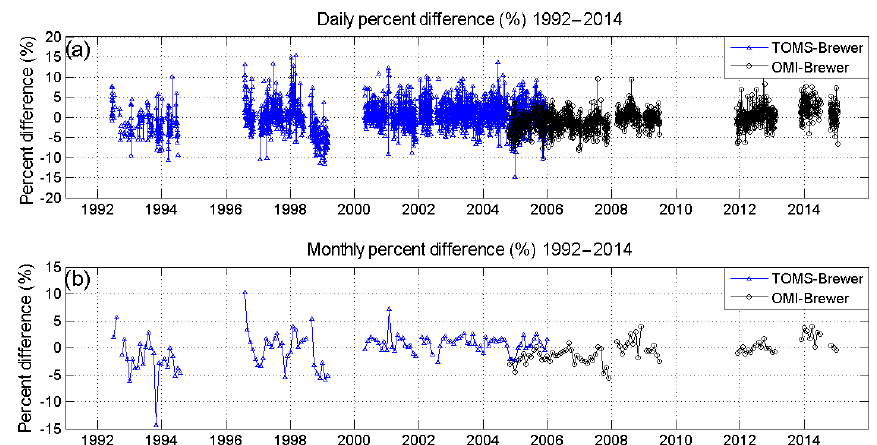
Figure 3. Top: time evolution of daily percentile differences between Brewer spectrophotometer and satellite instruments (with TOMS in blue and OMI in black). Bottom: time evolution of monthly percentile differences between Brewer spectrophotometer and satellite instruments (TOMS in blue and OMI in black). Both analyses the period between 1992 and 2014 for the Southern Space